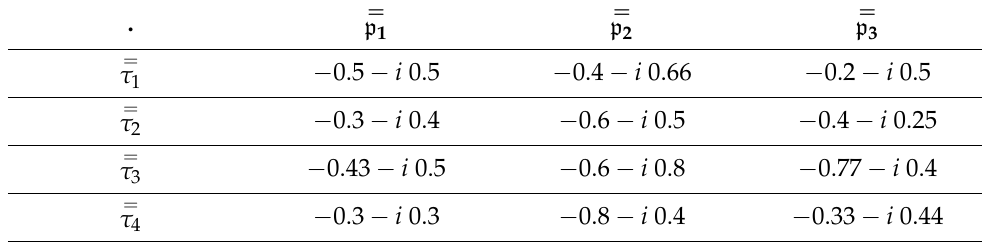
Table 13. The tabular description of NTG of scenario